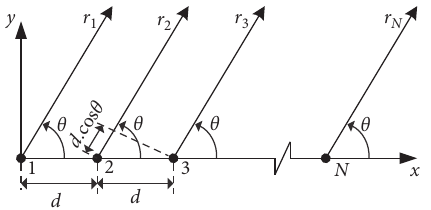
Figure 1: Antenna array for N isotropic elements.